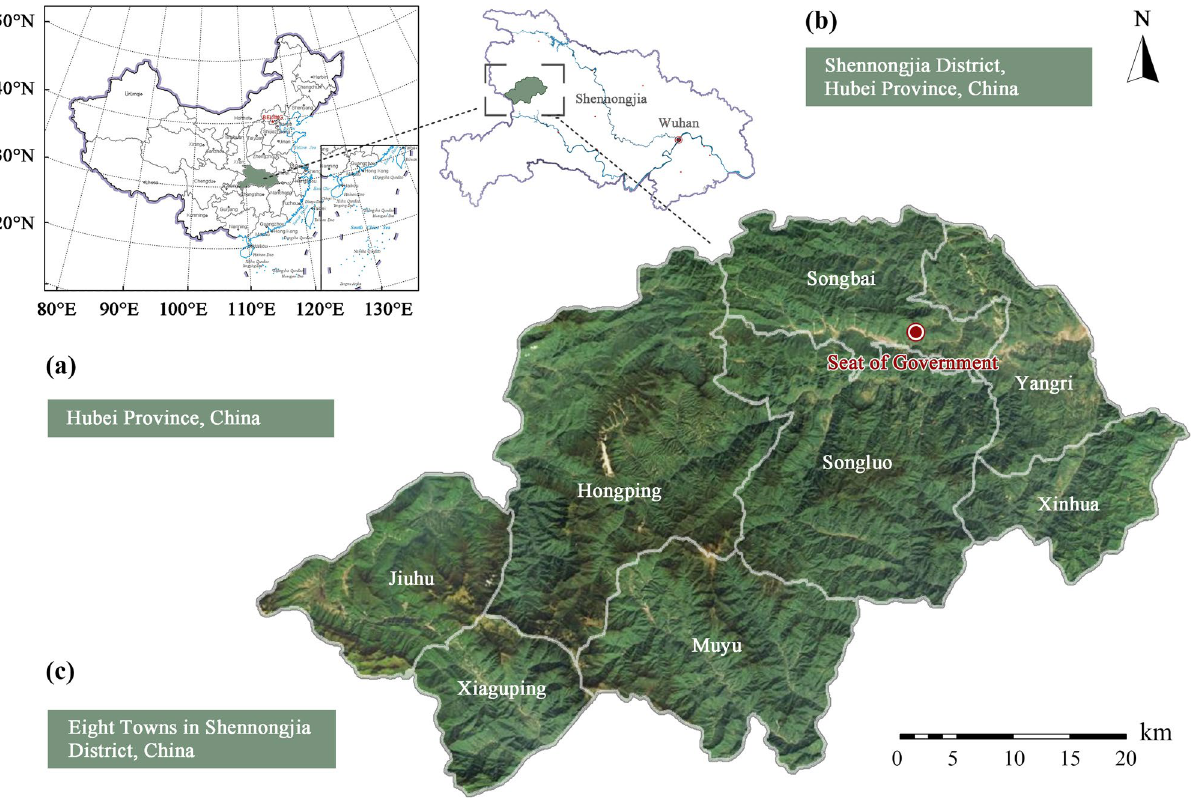
Figure 1. Location map of